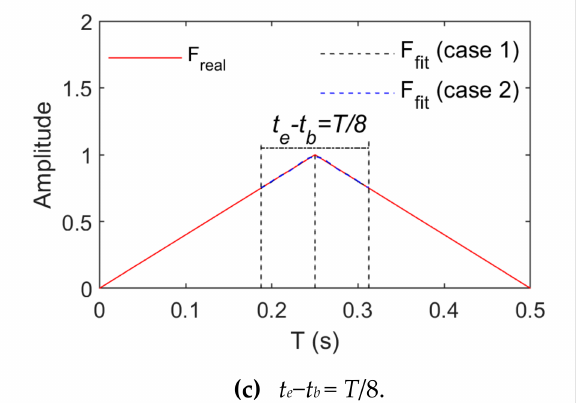
Figure 9. Comparison between real and fitting values of triangular wave loads ( f = 1 Hz).